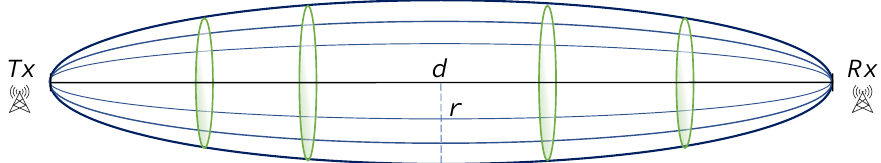
Figure 9. Illustration of the Fresnel zone between the transmitter and